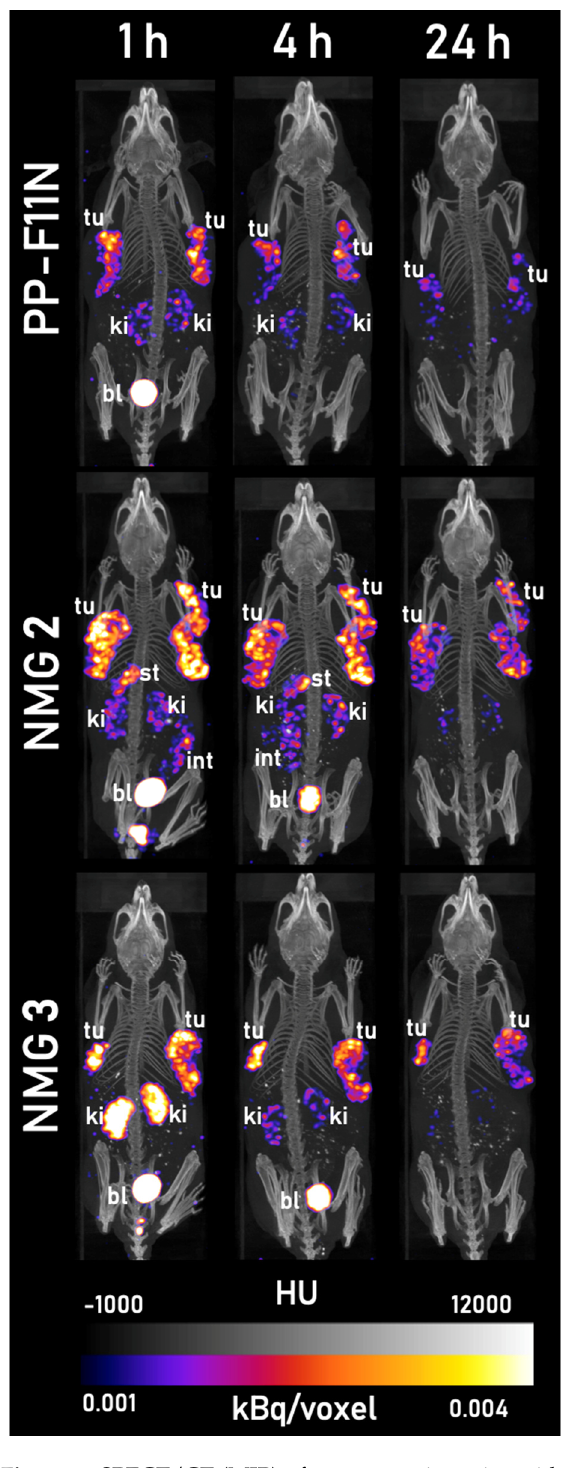
Figure 5. SPECT/CT (MIP) of representative mice with tumor xenografts at 1, 4, and 24 h p.i. of 177 Lu-labeled PP-F11N (top row), NMG 2 (middle row), and NMG 3 (bottom row). Color gradient represents intensities from 0.001 (dark purple) to 0.004 (light yellow) kBq/voxel of SPECT, black and white gradient refers to -1000 (black) to 12,000 (white) Hounsfield units (HU) of CT. Abbreviations used: tu = tumor xenograft, ki = kidney, bl = urinary bladder, int = intestines. Injections: 200 pmol, 100 µL, 2 µM, 20 MBq, 20 µg/kg. n = 2 animals per compound. SPECT/CT of all mice are available in the SI, Figure S9.